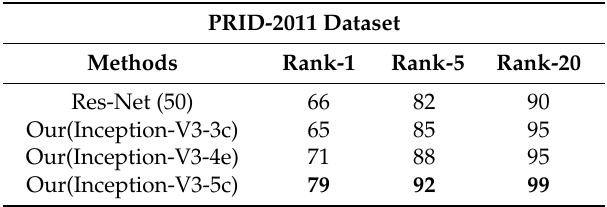
Table 7. Verification experiment results for the different Inception-V3 structures and different networks on the PRID-2011 dataset in terms of CMC